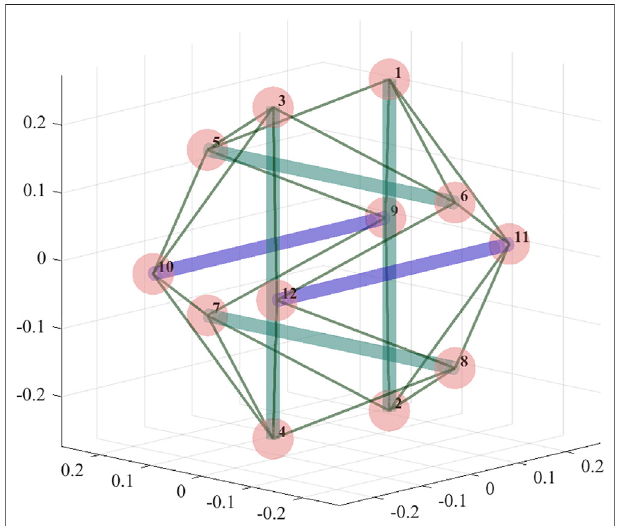
FIGURE 4 | A 6-bar tensegrity structure with two actuated rods (rods that can control their rest lengths), shown in blue; nodes of the structure are